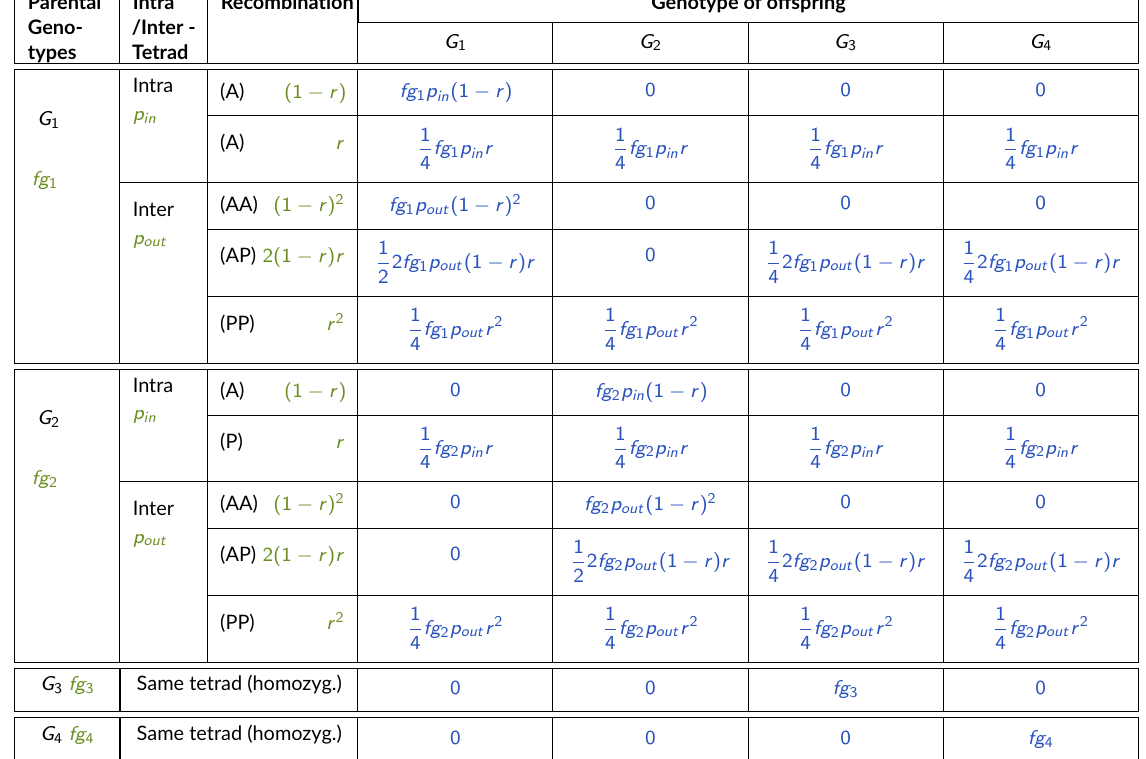
Table S2 – Table summarizing the rates of production of an offspring of each genotype (last four columns) in case of selfing . Parental Genotype : The genotype of the individual involved in the mating event; Intra/Inter-tetrad : Mating through intra- of inter-tetrad self- ing (see section 2.1 for definitions); Recombination : Occurrence of a recombination event in the tetrads from which gametes are picked. "A" stands for "Absence" in one tetrad, "P" stands for "Presence" in one tetrad. We use only one letter when the two gametes come from the same tetrad or when one of the genotypes involved is homozygous at the load locus. For example, (AP) indicates that recombination occured in one tetrad but not in the other. G i : the rate at which an offspring of genotype G i is produced, due to the scenario of parental genotype, intra/inter tetrad selfing and presence/absence of recombination considered. The total rate T g (+ G i ) at which a new offspring of genotype G i is created when the population state is g = ( g 1 , g 2 , g 3 , g 4 ) is then the sum of all the rates appearing in column G i in this Table, Table S3 and Table